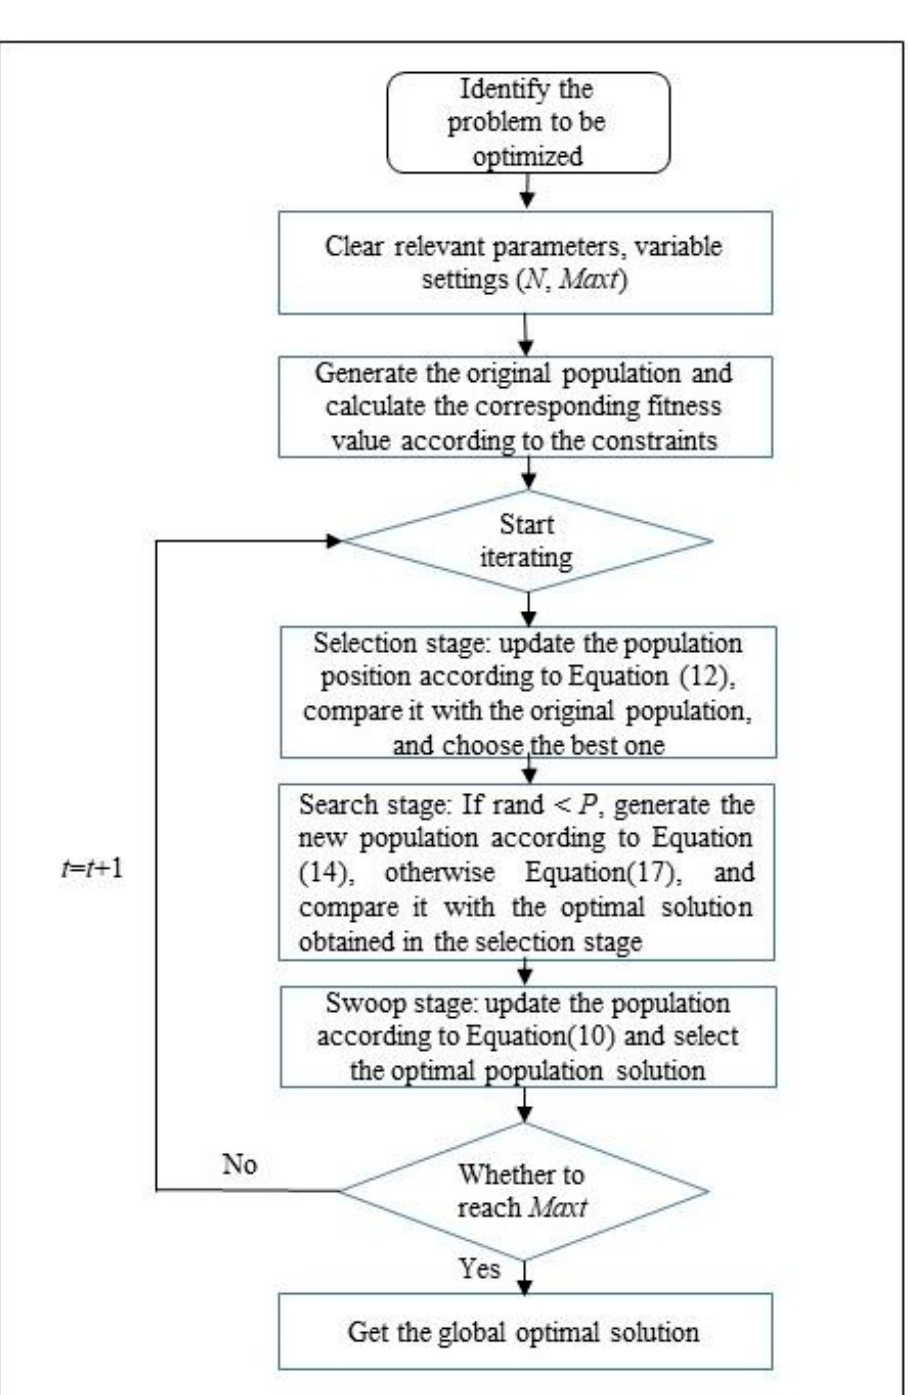
Figure 1. Flow chart of CABES algorithm.